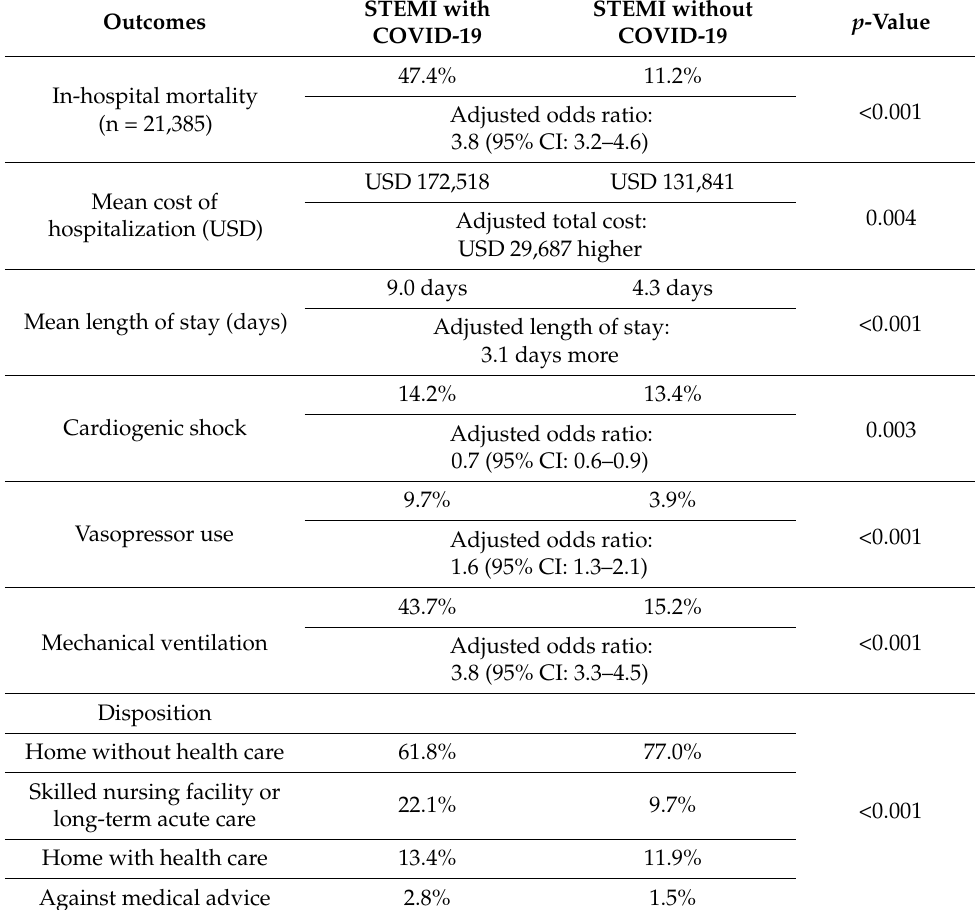
Table 2. STEMI Primary and Secondary Non-Cardiac Procedural Outcomes Based on COVID-19 Status.